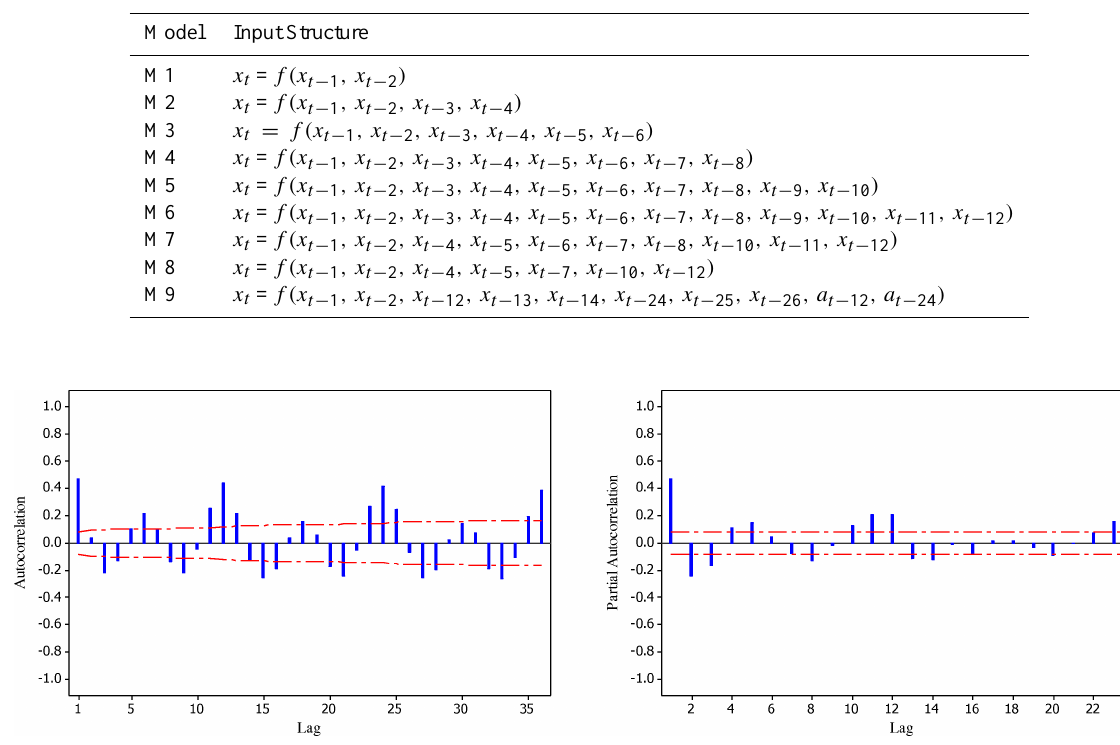
Fig. 7. The autocorrelation and partial autocorrelation of river flow series of Selangor River.